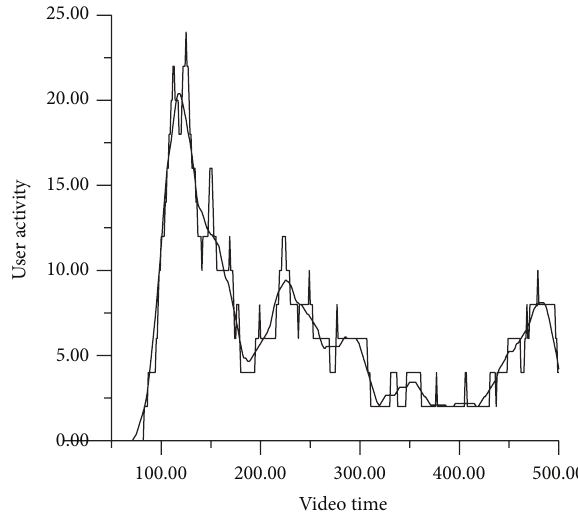
Figure 2: The user activity signal is approximated with a smooth signal. The 𝑦 -axis is the measured user activity while the 𝑥 -axis is the relativevideotimeinseconds.Thesamenotationisusedthroughout the